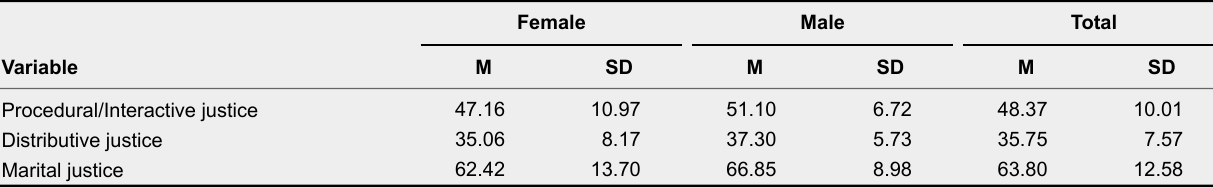
Means and Standard Deviations for the MJS and its Subscales TotalMaleFemale Variable